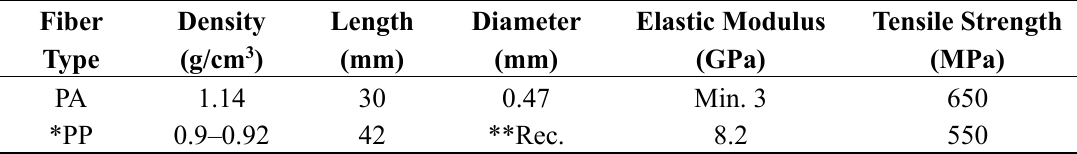
Table 1. Material properties of PA and PP